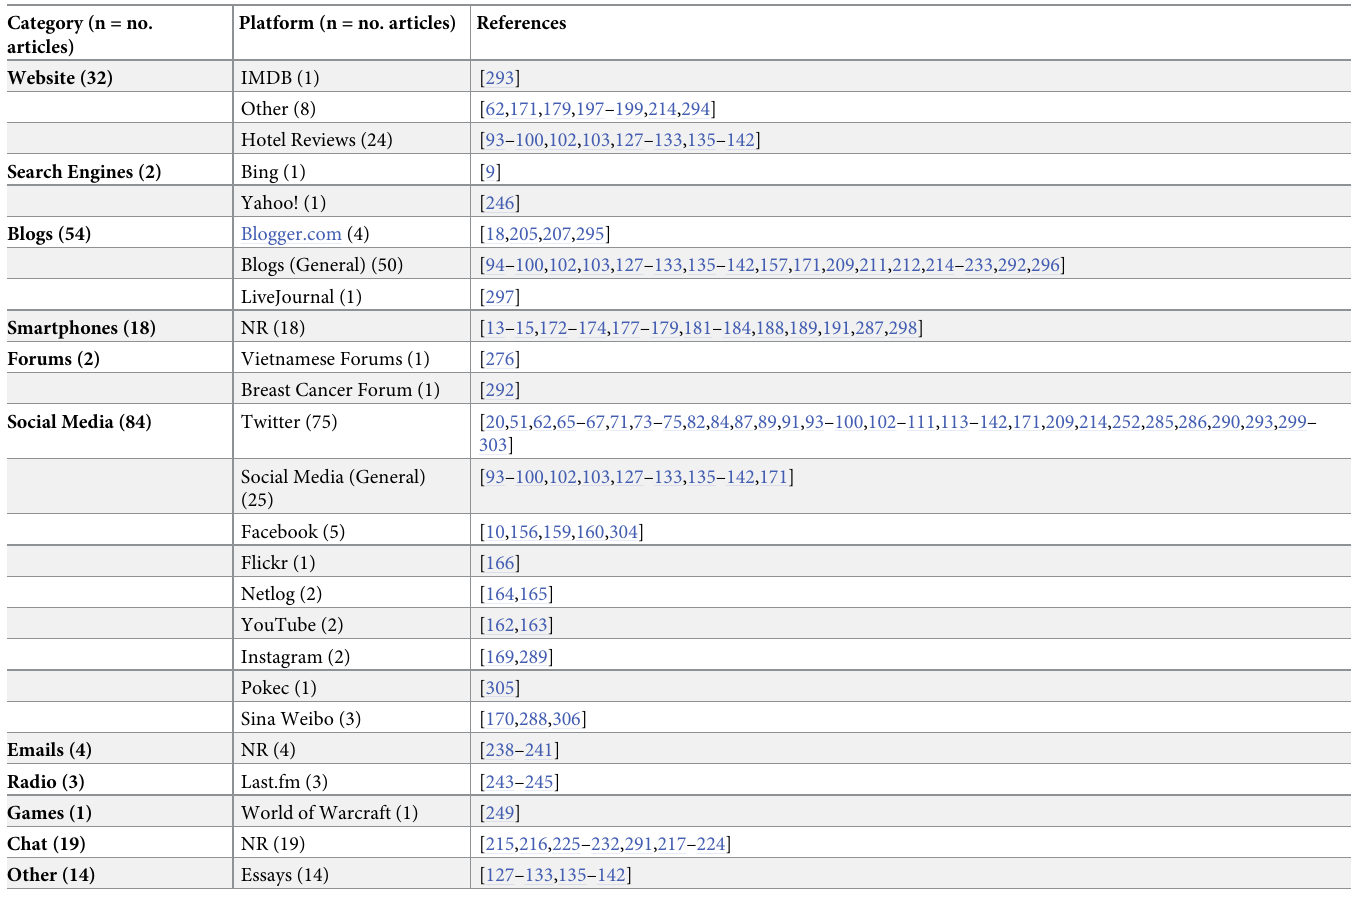
Table 3. Number of articles predicting age, with associated platforms and references. Category (n = no.